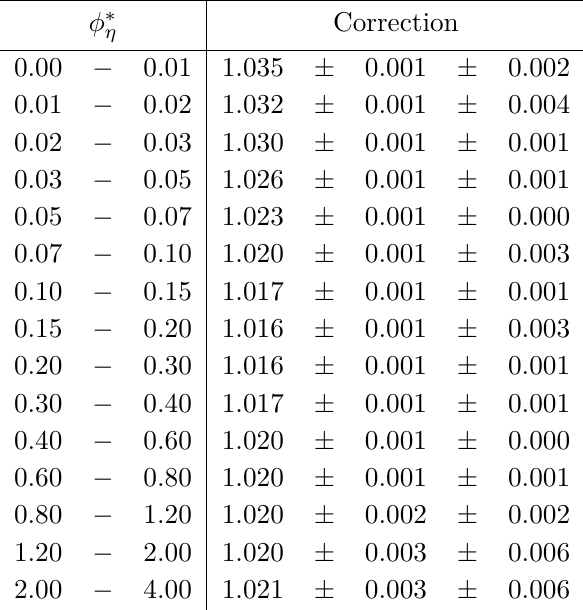
Table 4 . Final state radiation correction used in the φ ∗ uncertainty is statistical and the second is